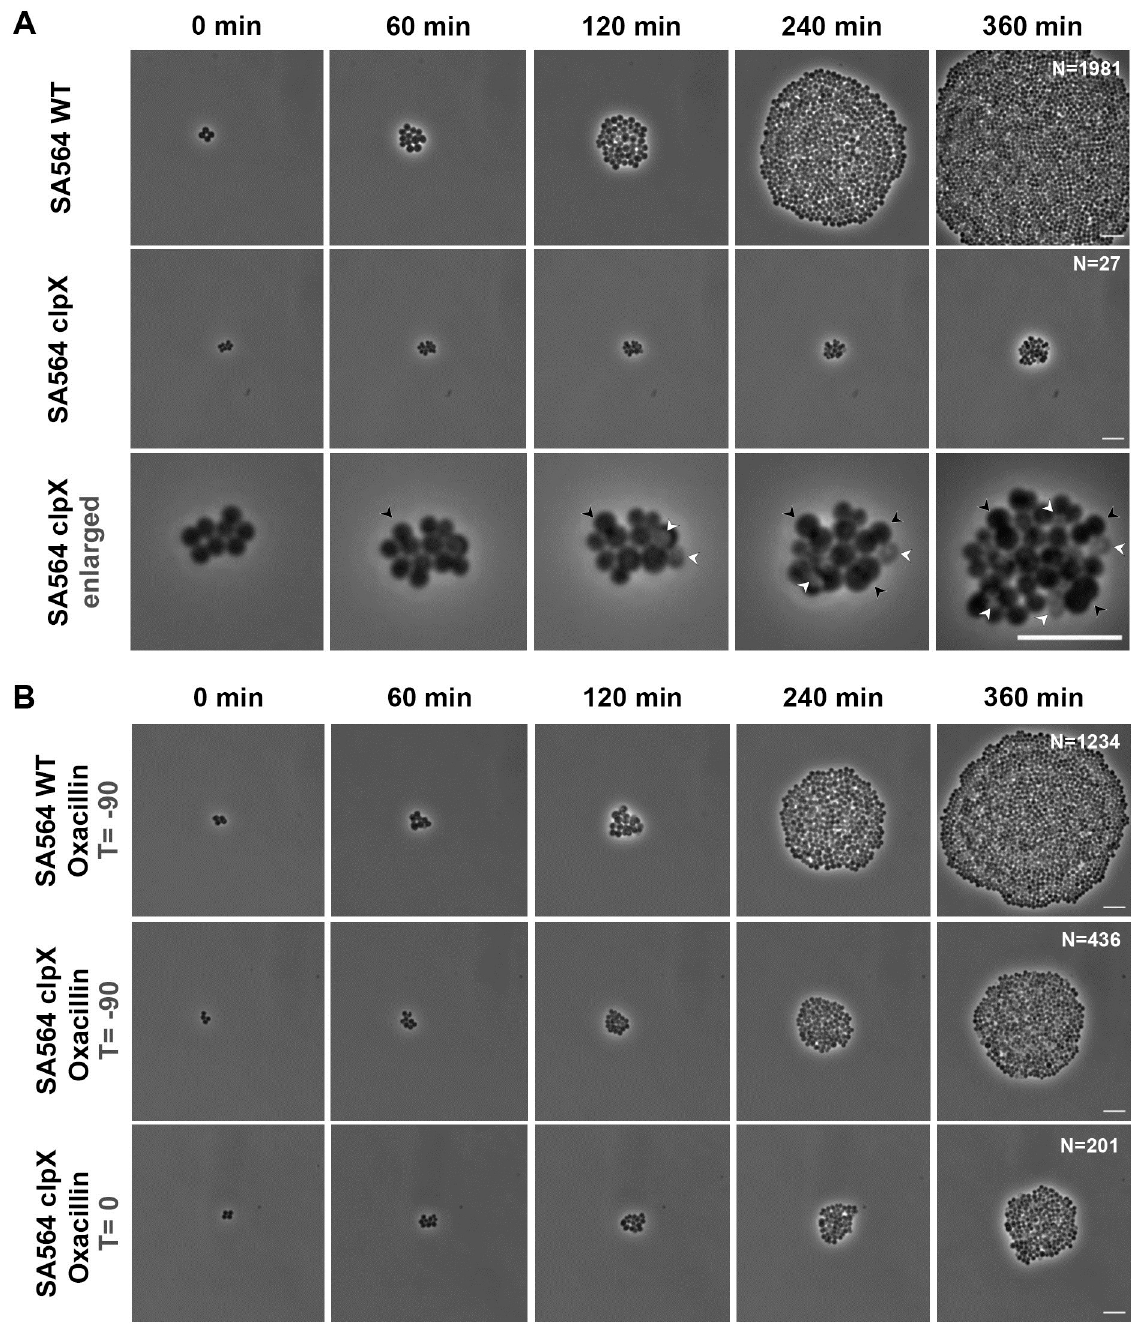
Fig 2. Single cell analysis reveals that oxacillin prevents premature growth arrest and spontaneous lysis of S . aureus clpX mutants. Still images from time-lapse microscopy (phase contrast) of SA564 wild-type and clpX cells growing on a semisolid surface at 30˚C, without ( A ) or supplemented with 0.01 μ g ml -1 oxacillin ( B ). In the upper and middle panel (T = -90) cells were exposed to 0.01 μ g ml -1 oxacillin 90 min prior to imaging; in the lower panel (T = 0), clpX cells were grown in the absence of oxacillin prior to imaging. The still images are taken from movies (see S1 Movie) showing the typical growth of one micro-colony among at least 20 imaged micro colonies, except that the clpX cells depicted in (A) belong to the minority of clpX cells that were capable of initiating growth and forming a micro colony. N, corresponds to the number of living cells at the endpoint (T = 360). Scale bar, 5 μ